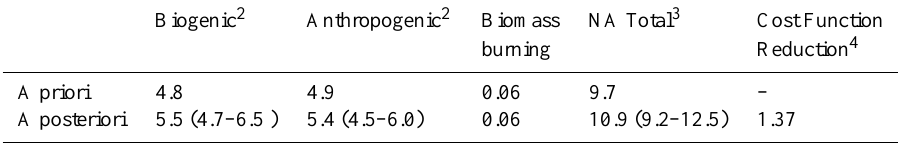
Table 2. North American 1 acetone sources (Tg a − 1 ) : A priori forward model sources and a posteriori sources optimized based on the KCMP tall tower measurements. 95% confidence intervals for the optimized posteriori sources are provided in parentheses.